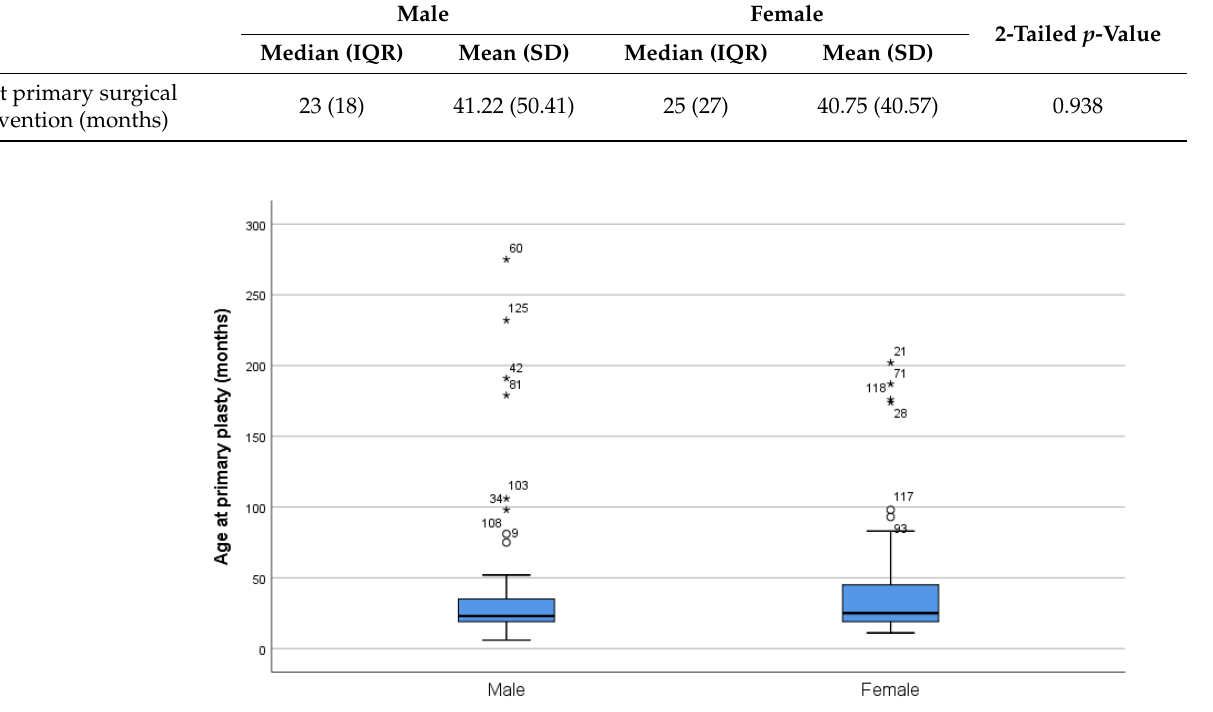
Figure 2. Ages of the male and female patients at their primary surgical intervention. “*”—outliers.